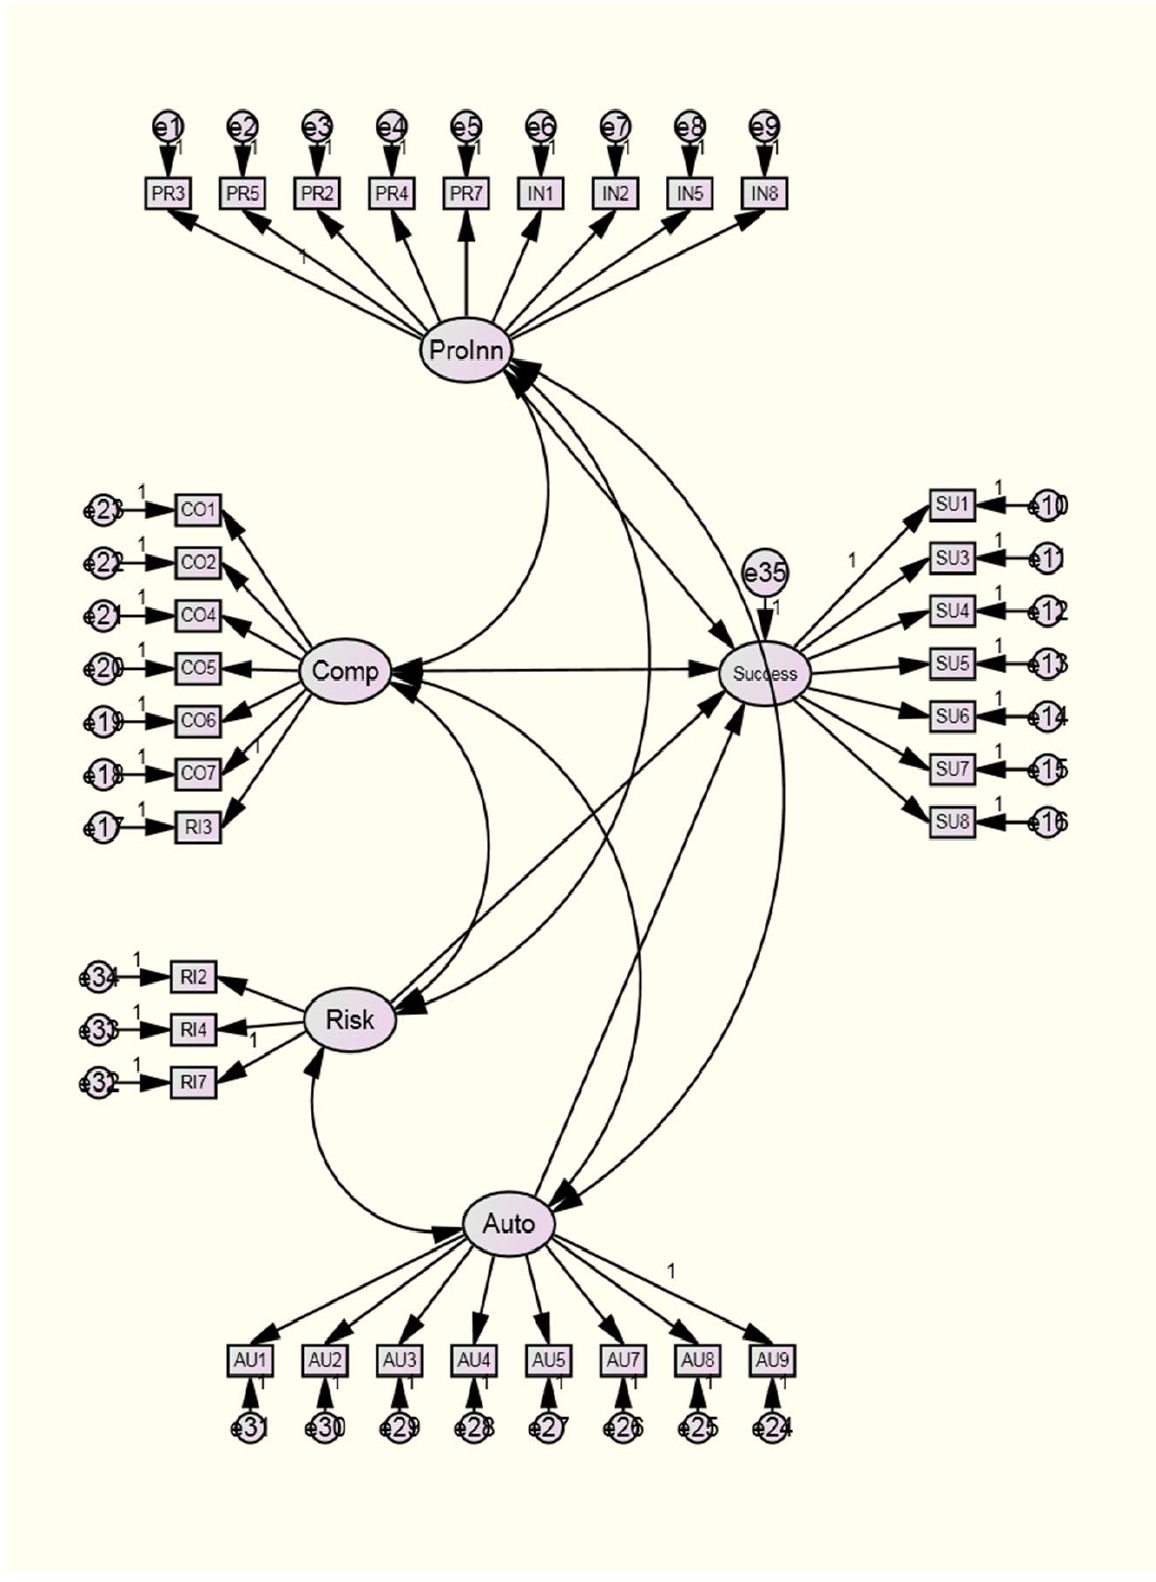
FIGURE 1 STRUCTURAL